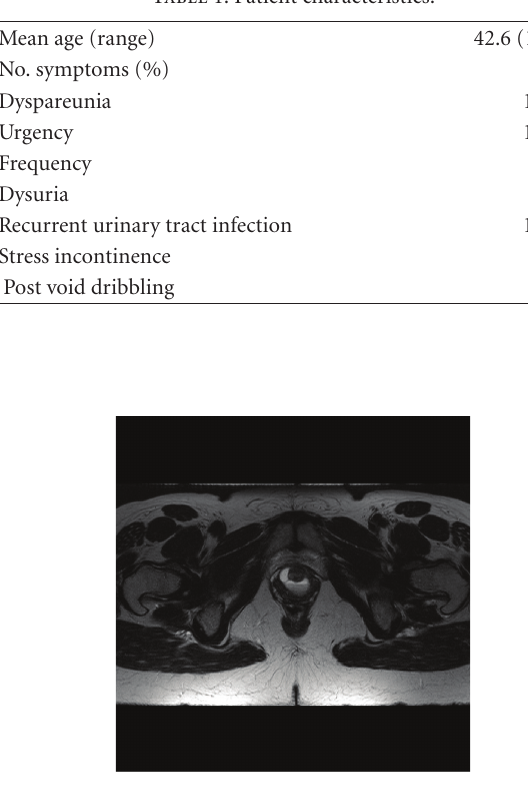
Figure 1: Urethral diverticulum on MRI (T2 weighted, fast spin echo). Patient presented with dyspareunia, urinary urgency and a normal physical exam. VCUG showed no evidence of urethral diverticulum. MRI revealed the correct